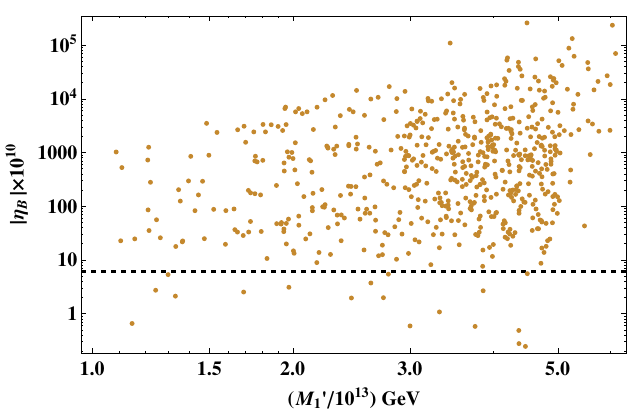
for normal 1 = (6 . 12 ± 0 . 04) × 10 − 10 B |